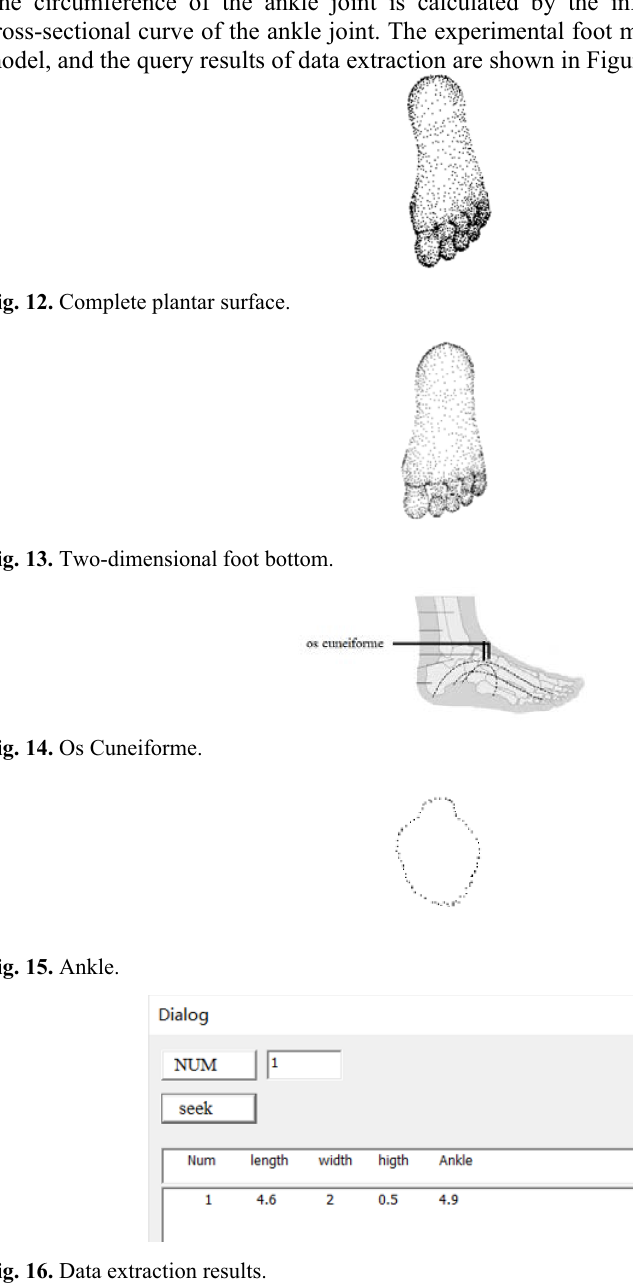
Fig. 16. Data extraction